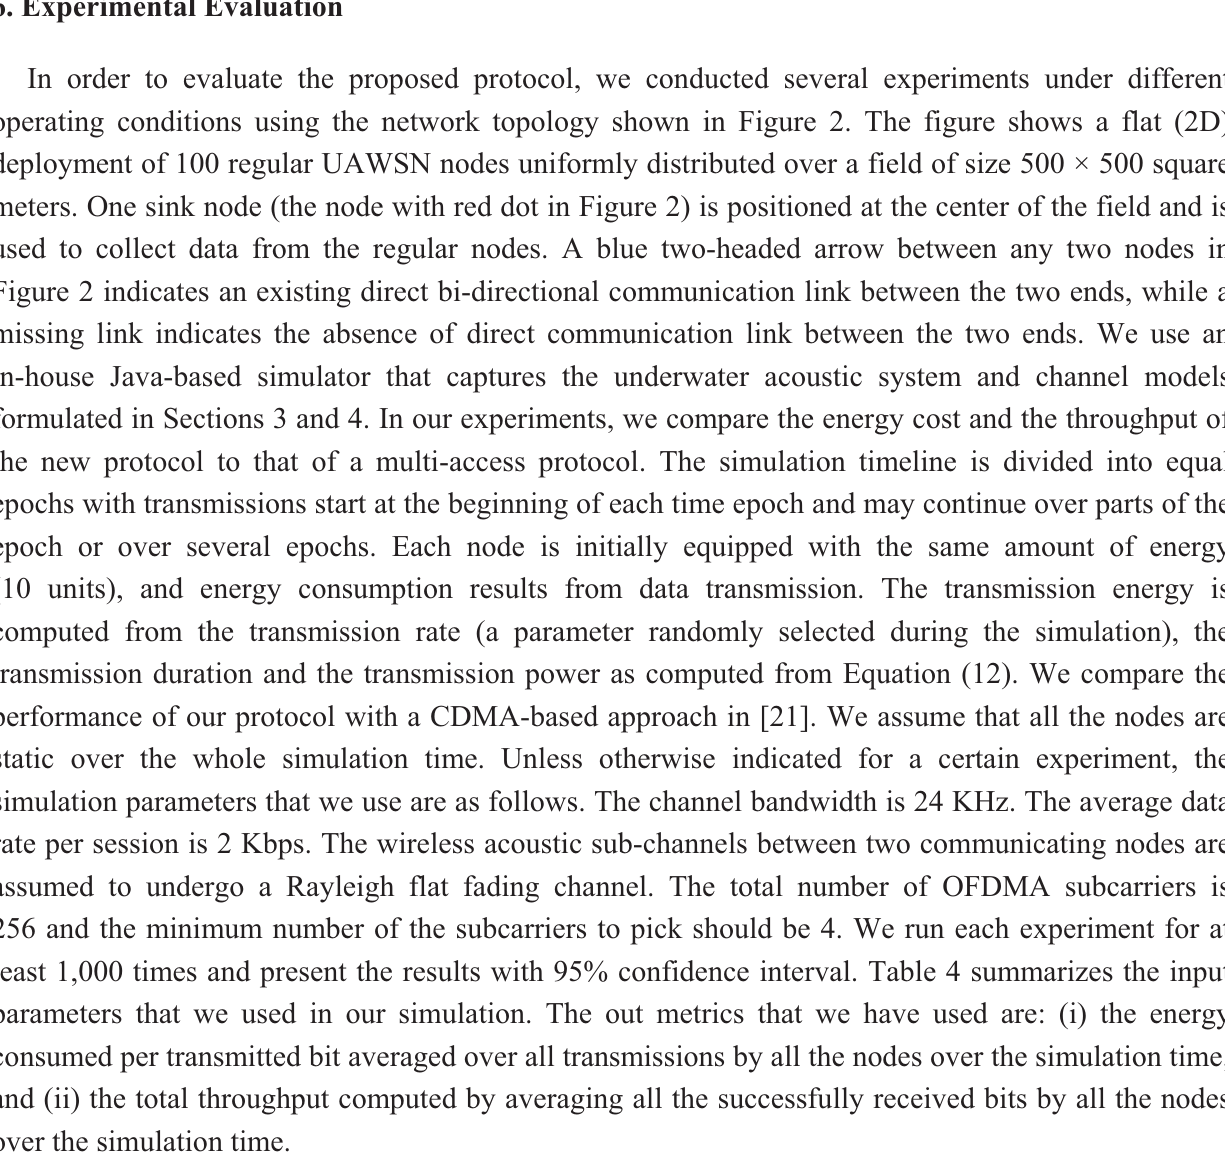
Figure 2. 2-D network